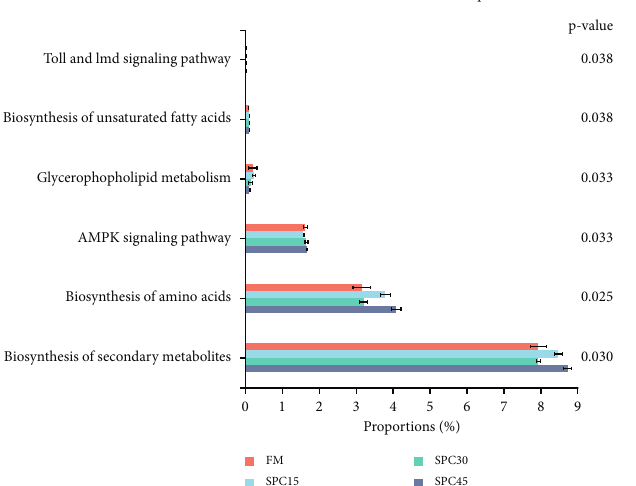
Figure 7: Functional analysis of the microbial composition of large yellow croakers fed the experimental diets. Di ff erences were considered signi fi cant at P < 0 : 05